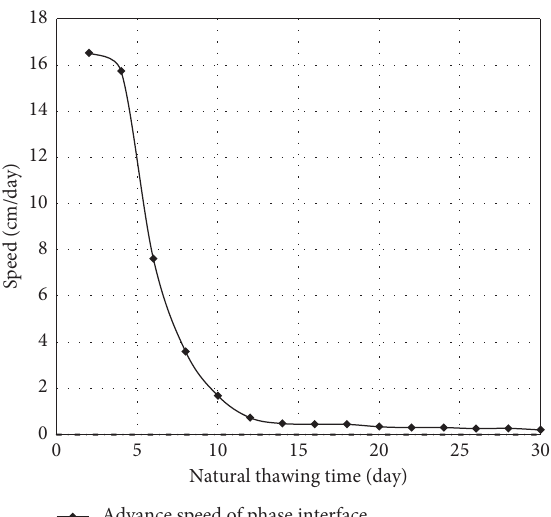
Figure 11: Variation of advance speed of phase interface with natural thawing